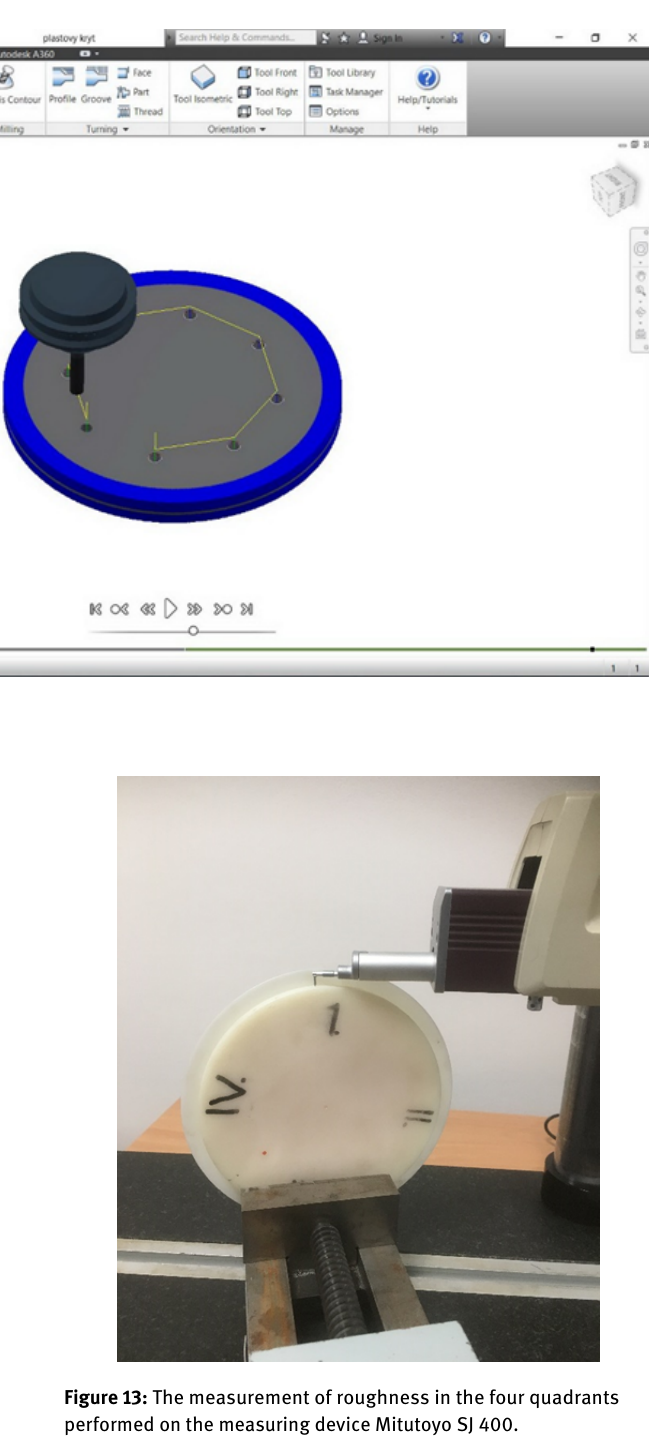
Figure 12: Manufacturing of the conical surface on CNC lathe.